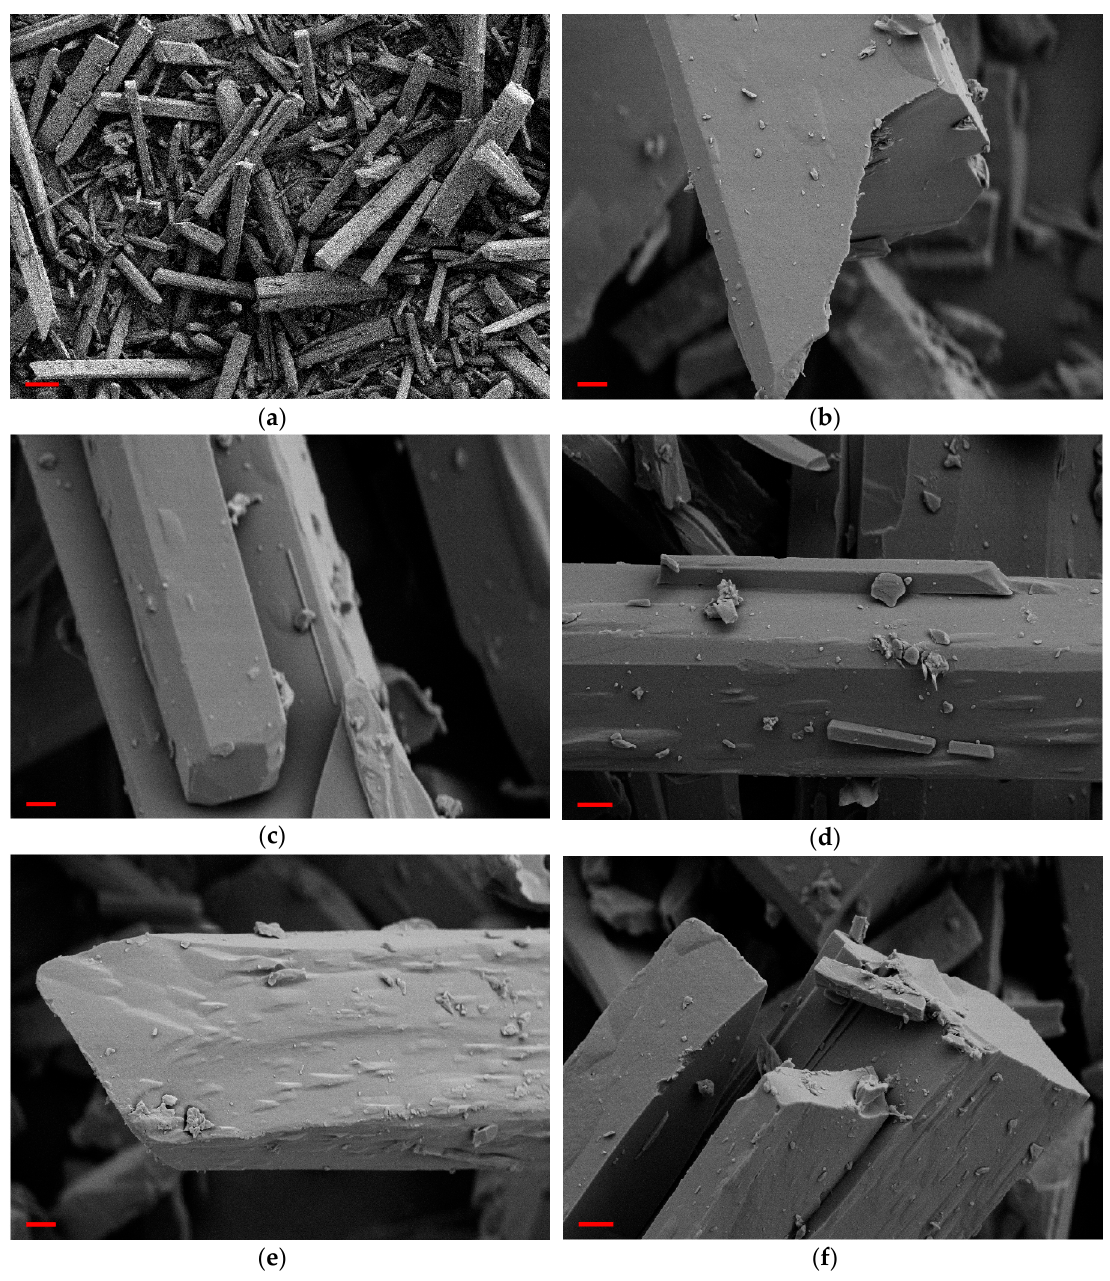
Figure A1. FE-SEM images of ampicillin trihydrate initial crystals. The scale bar is 30 µ m in ( a ) and 2 µ m in ( b – f ). Image ( a ) shows uniformity of initial crystals, ( b ) shows a fracture and splinter of an initial crystal, ( c , d ) show epitaxial growth and possibly twinning, ( e , f ) show ends of initial crystals.